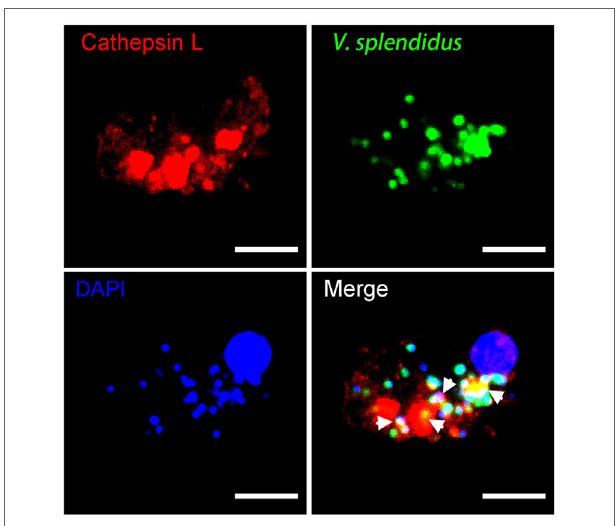
FigUre 9 | The involvement of cathepsin L in hemocyte phagocytosis of Vibrio splendidus . Hemocytes were incubated with FITC-labeled V. splendidus to allow hemocyte phagocytosis. Subsequent to cell fixation and permeabilization, hemocytes were stained with polyclonal IgG against rCathepsin L and then subjected to Alexa Fluor 594-labeled anti-mouse IgG antibody staining. diamidino-2-phenylindole (DAPI) was used to mark the cell nucleus, and each image was captured at a single focal plane using confocal microscopy. Interactions between cathepsin L and engulfed microbes are denoted here with white arrows; scale bar: 10